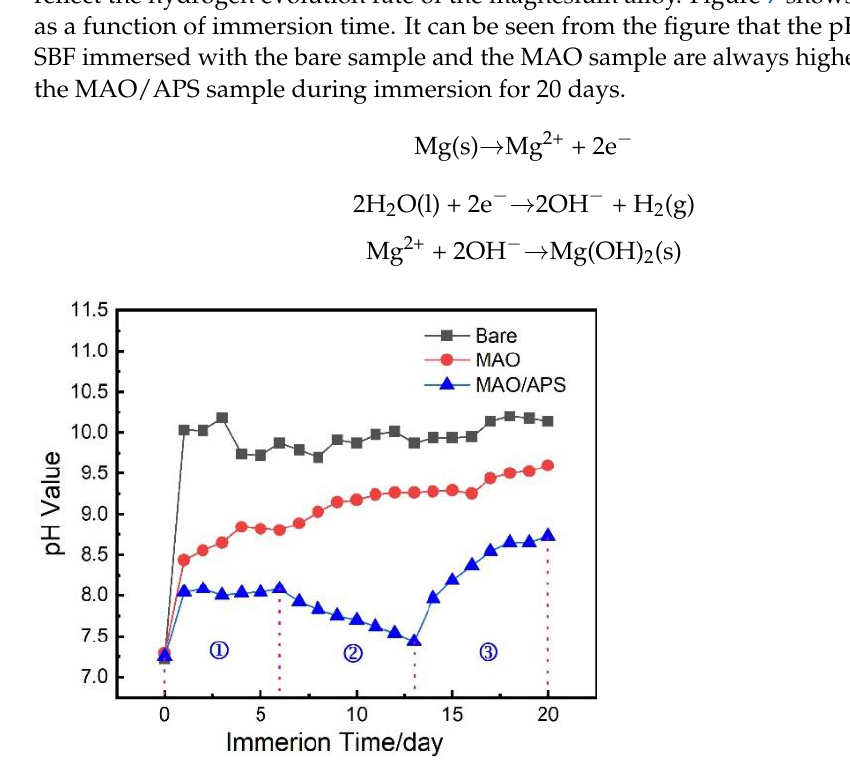
Figure 7. pH values of the SBF during immersion test. The early stage of immersion is 0–6 days, which is tagged with 1 in Figure 7; middle- term of immersion is 7–13 days, which is tagged with 2 in Figure 7; late-term immersion is 14–20 days, which is tagged with 3 in Figure